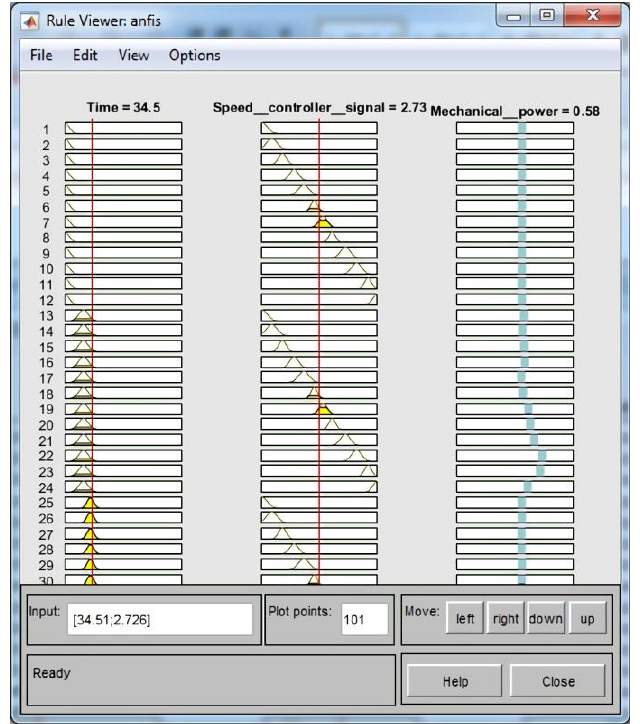
Figure 14. Diagram of the fuzzy logic inference system of the Sugeno type (144 rules).